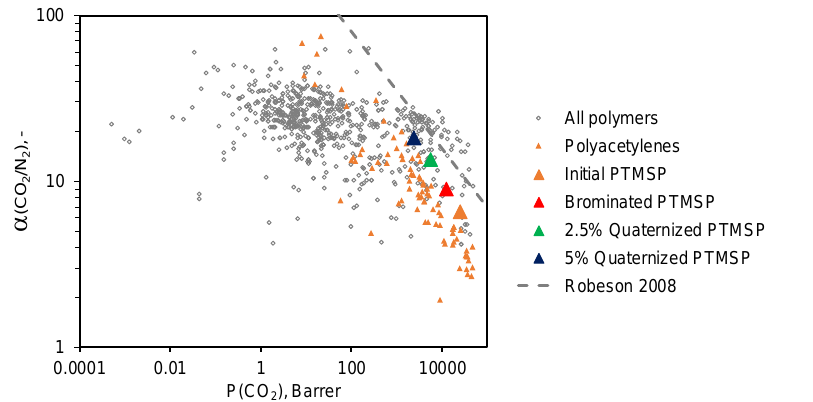
Figure 6. Position of studied polymers on the Robeson plot with 2008 upper bound for CO 2 /N 2 separation. The gas transport data for polymers reported in the literature are taken from the Polymer Gas Separation Membrane Database of the Membrane society of Australasia [30].